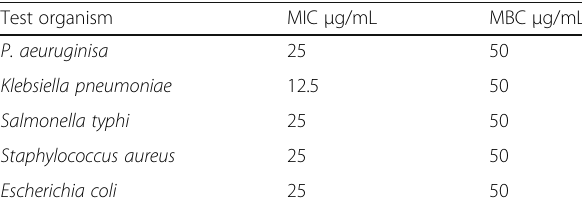
Table 6 Minimum inhibitory concentration (MIC) and minimum bactericidal concentration (MBC) of the extract Test organism